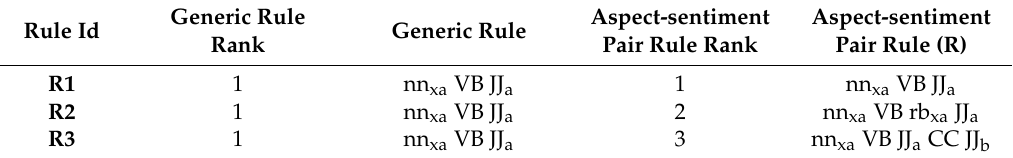
Table 9. Aspect-sentiment pair rule